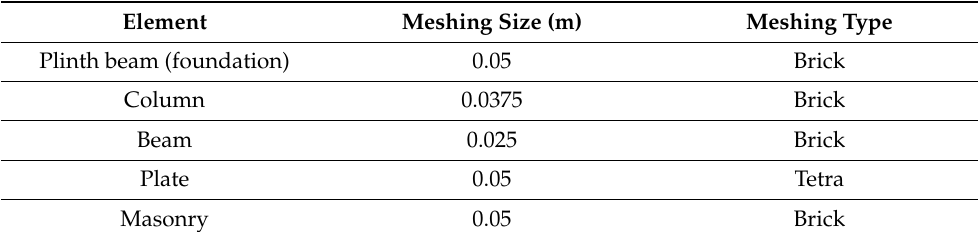
Table 3. Meshing configuration of meso modeling. Element Meshing Size (m) Meshing Type Plinth beam (foundation) 0.05 Brick Column